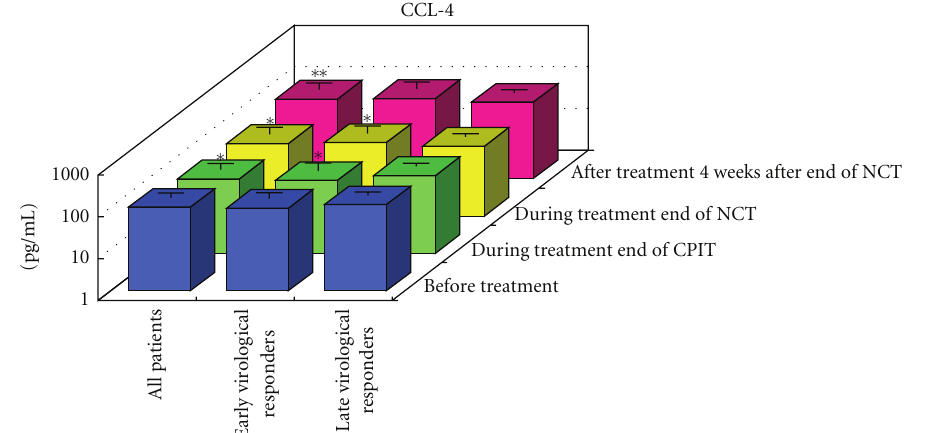
Figure 5: E ff ect of RBV plus PEG-IFN-alpha 2b using an “induction” approach with CPIT (NCT) on serum CCL-4 in chronic hepatitis C patients with high viral load, genotype 1b (serotype I), and wild or intermediate type of ISDR. RBV: ribavirin, PEG-IFN: pegylated interferon, CPIT: cyclic and periodic interferon treatment, NCT: novel combination treatment. Significant di ff erence: ∗ P < 0 . 05, ∗∗ P < 0 . 1.